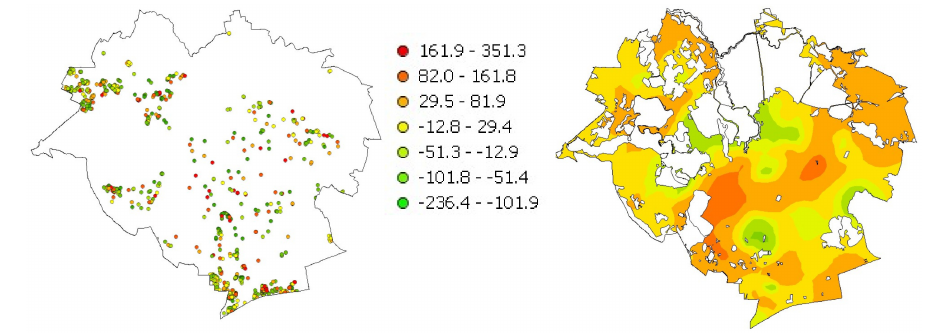
Figure 5. Spot and spatial distribution of the GWR model residuals.